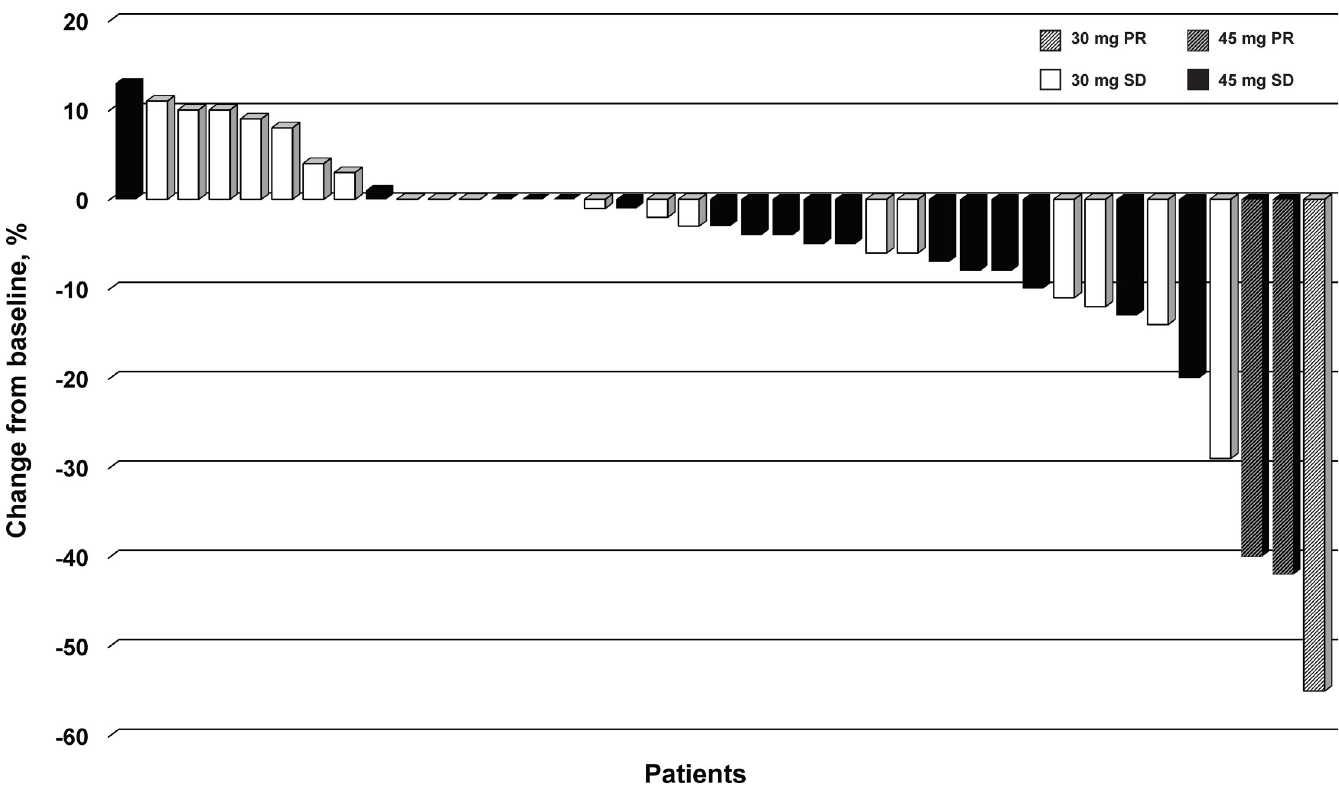
Fig 2. Waterfall plot of tumor response according to RECIST version 1.1 in patients treated with CC-223, by starting dose. Best percent change from baseline in the sum of the longest diameters of target lesions (n = 39). PR, partial response; RECIST, Response Evaluation Criteria In Solid Tumors; SD, stable disease.